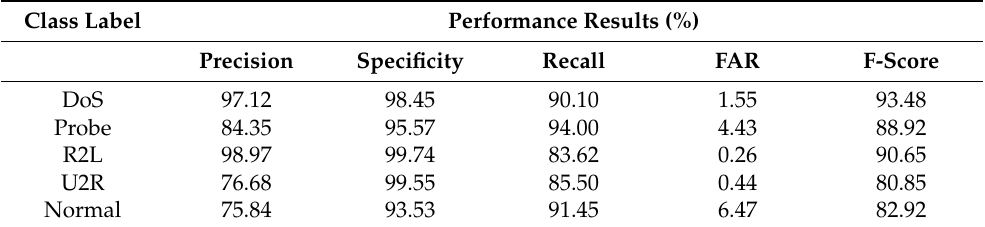
Table 18. BidLSTM performance results on NSL-KDDTest − 21 using 17